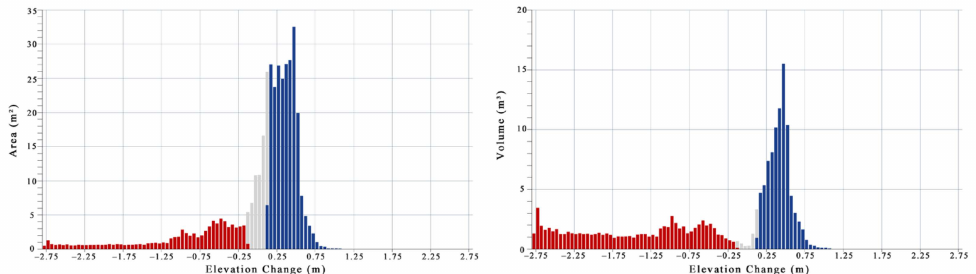
Figure 12. Histograms of areal and volumetric change distribution. Positive values indicate deposi- tion, and negative values indicate